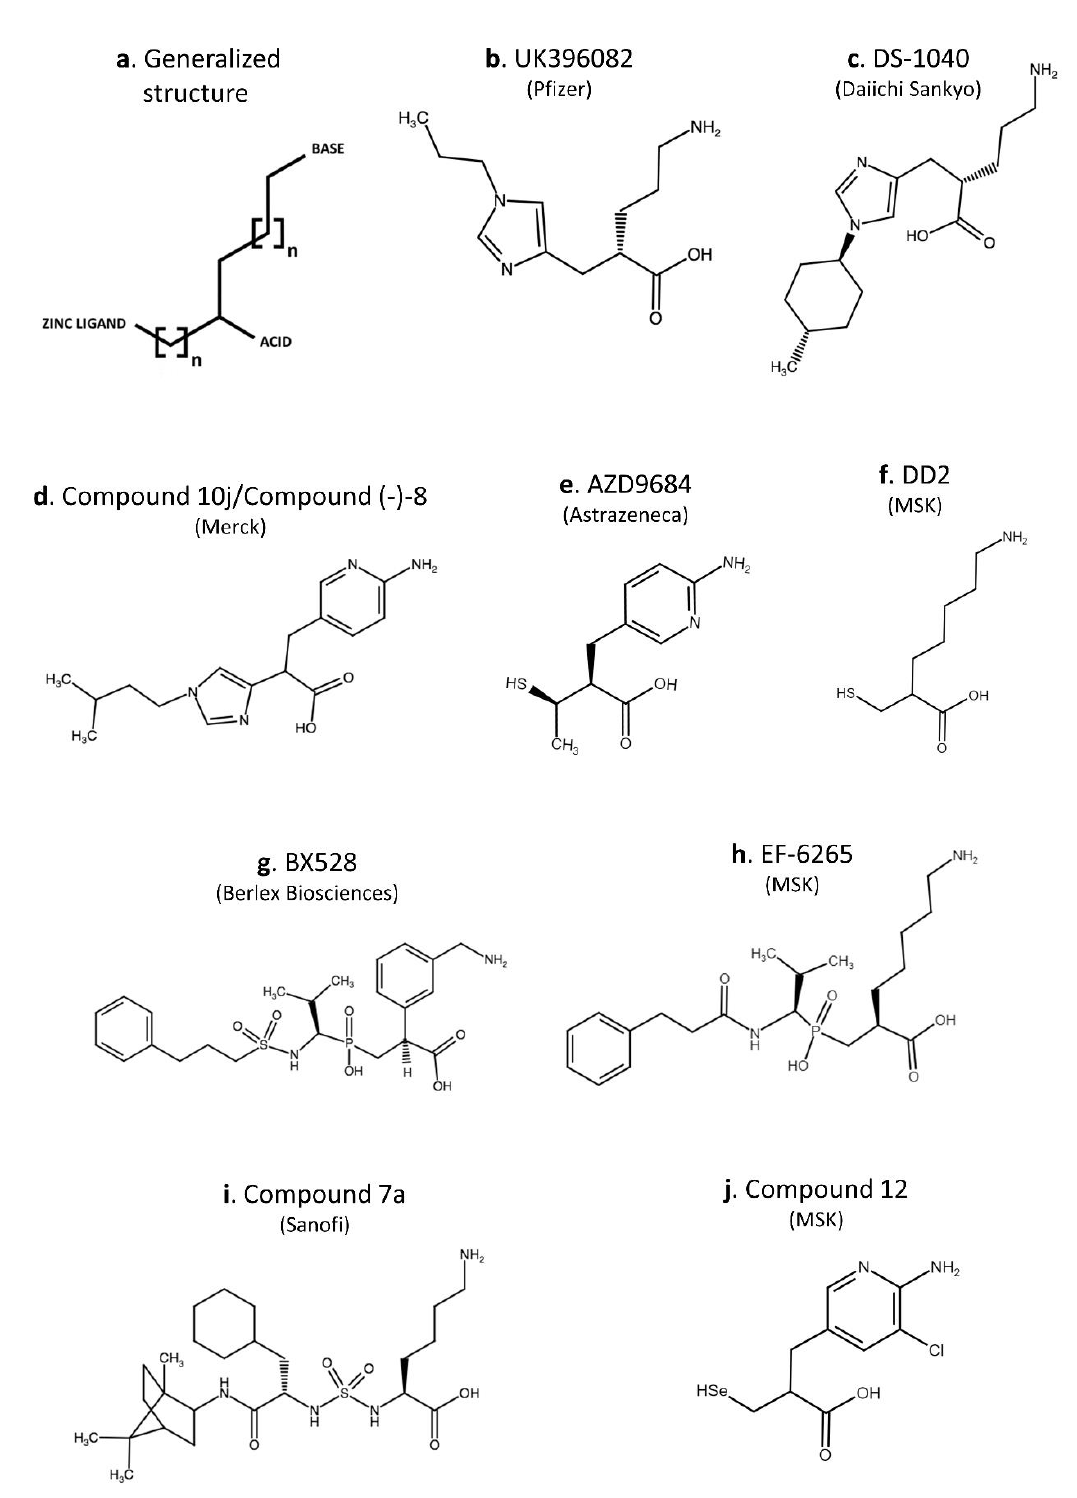
Figure 3. General structure of a low molecular weight (LMW) carboxypeptidase inhibitor ( a ; based on Bunnage et al. [146]) and structures of selective LMW carboxypeptidase U inhibitors disclosed to date ( b – j ). Inhibitors containing an imidazole—( b – d ), thiol—( e , f ), dialkyl phosphinic acid—( g – h ), sulfamide—( i ) or selenium-group ( j ) as the functional group involved in the Zn 2+ -coordination.